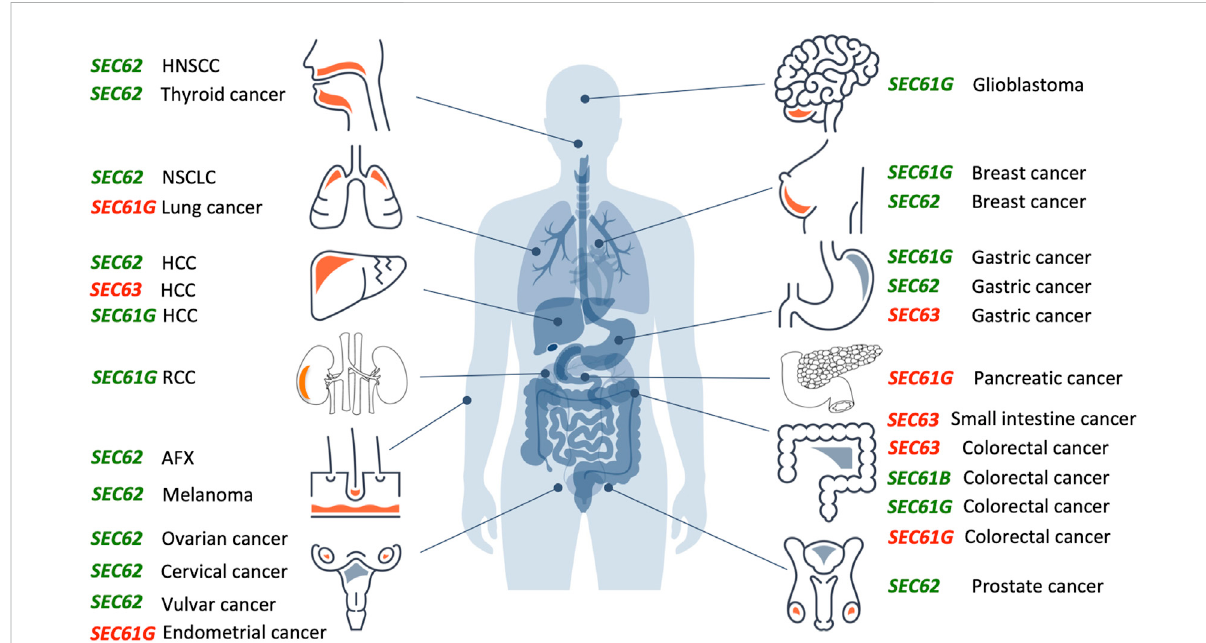
FIGURE 3 Overproduction or mutation of SEC61 , SEC62 and SEC63 genes are associated with various human tumor diseases. Overview of genetic changes and altered expression of SEC61 , SEC62 , and SEC63 gene in human cancer entities segregated by the tissue of origin (from top left to bottom right: head and neck, lung, liver, kidneys, skin, female genital tract, brain, breast, stomach, pancreas, intestine, male genital tract). Green colored genes symbolize functional gain by overexpression and ampli fi cation, red colored genes symbolize functional loss by low expression, deletion,ormutation.AFX,atypical fi broxanthoma;HCC,hepatocellularcarcinoma;HNSCC,headandnecksquamouscellcarcinoma;NSCLC,non- small cell lung cancer; RCC, renal cell carcinoma.The Figure and Figure legend were adapted from Sicking et al.